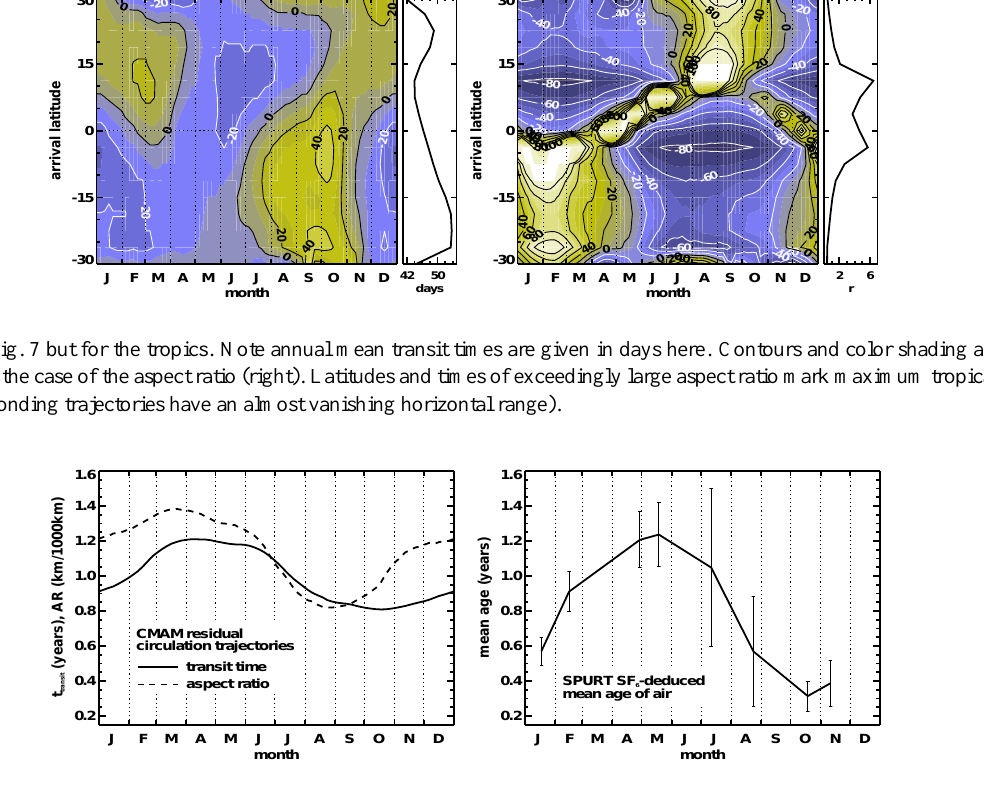
Fig. 10. Left: annual cycles of residual circulation transit time (full line, years) and trajectory aspect ratio r (dashed line, km per 1000 km) averaged over [40 ◦ N, 80 ◦ N] for CMAM. Arrival pressure is set to correspond to Θ TP +30 K. Right: annual cycle of SF 6 -deduced mean age of air from SPURT averaged over equivalent latitudes [40 ◦ N, 80 ◦ N] and [ Θ TP +25 K, Θ TP +35 K] (data identical to that used in B¨onisch et al., (2009)).